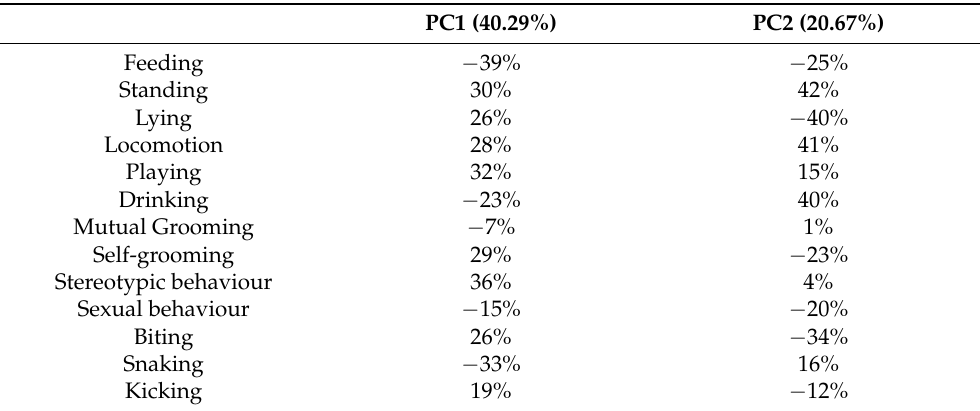
Figure 1. Principal component analysis biplot (PC1 and PC2) performed on selected behavioural activities by horses belonging to HCG and HFG. Table 3. Principal component analysis loadings of behavioural activities performed by horses belonging to HCG and